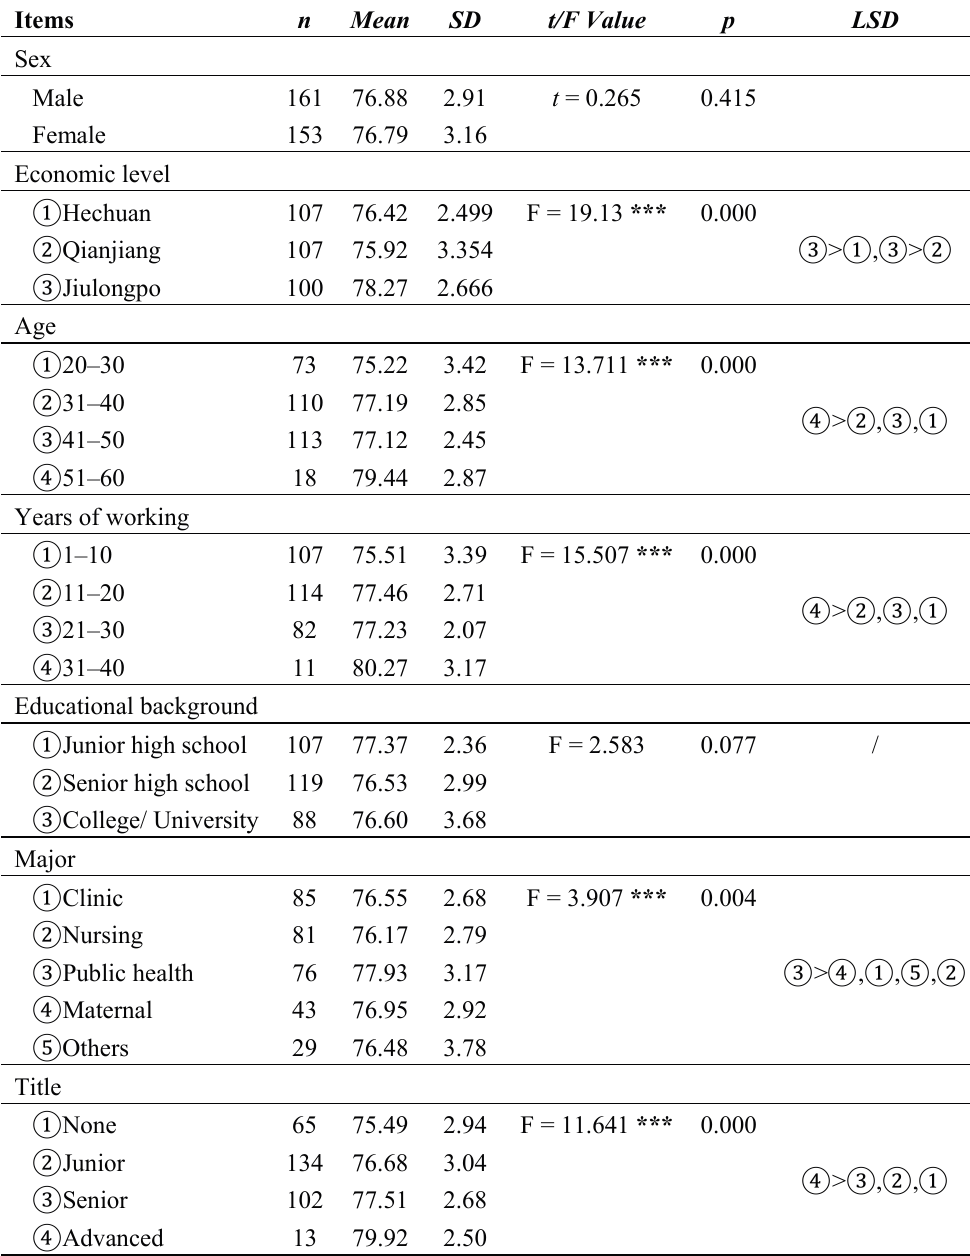
Table 4. Relationship between factors of PHWs and self-evaluated